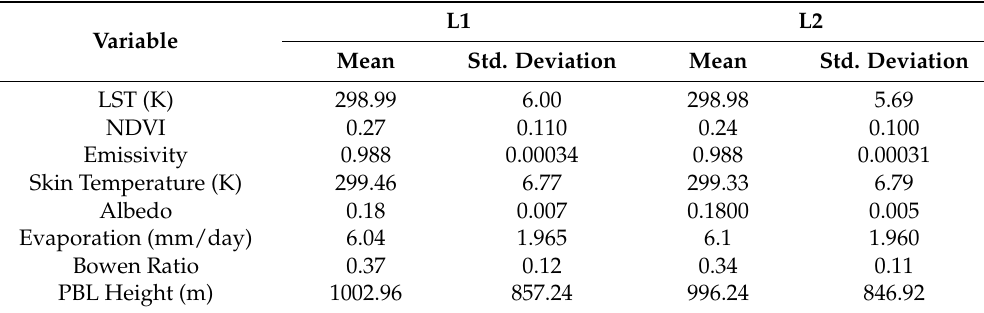
Table 1. Mean and standard deviation of various variables in L1 (NE-SW) and L2 (NW-SE) transect. Number of samples for Landsat derived variables for L1 = 4572 and for L2 = 3972. For ERA-Interim derived variables the number of samples is 108 for both